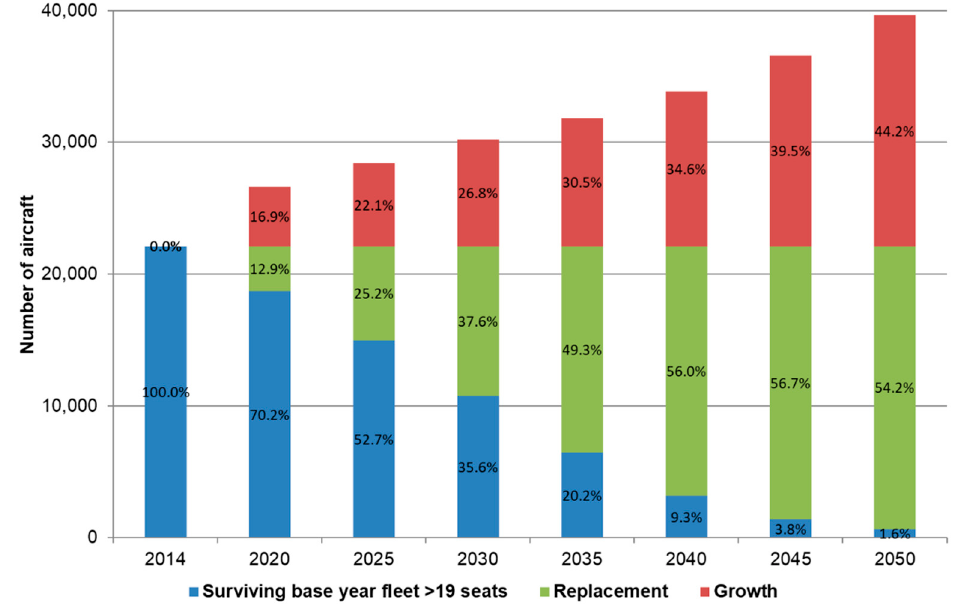
Figure 20. Passenger-in service fleet breakdown in the High Scenario.